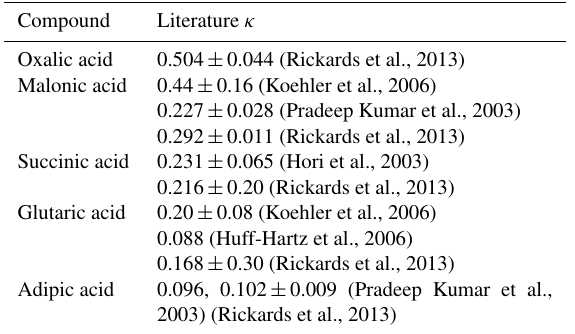
Table 2. κ values available in the literature for dicarboxylic